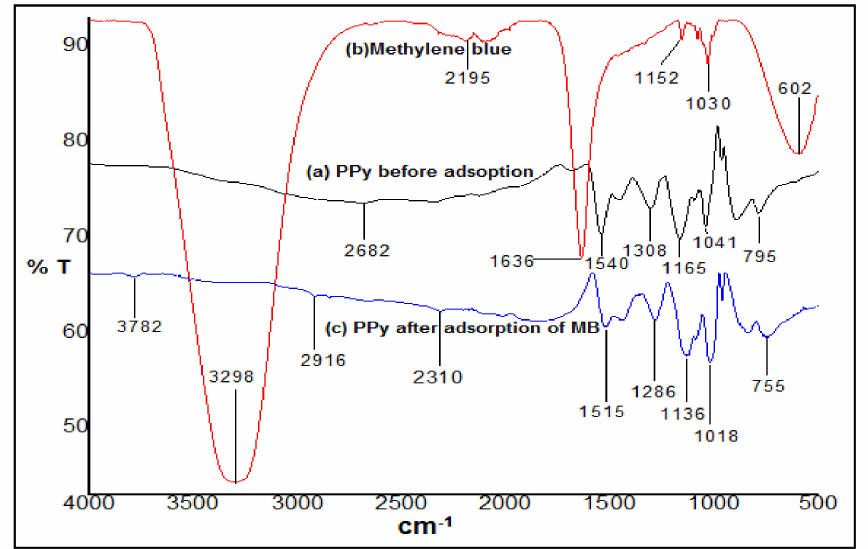
Figure 4. FTIR spectra of ( a ) PPy fine powder before adsorption, ( b ) MB , and ( c ) PPy after adsorption of methylene